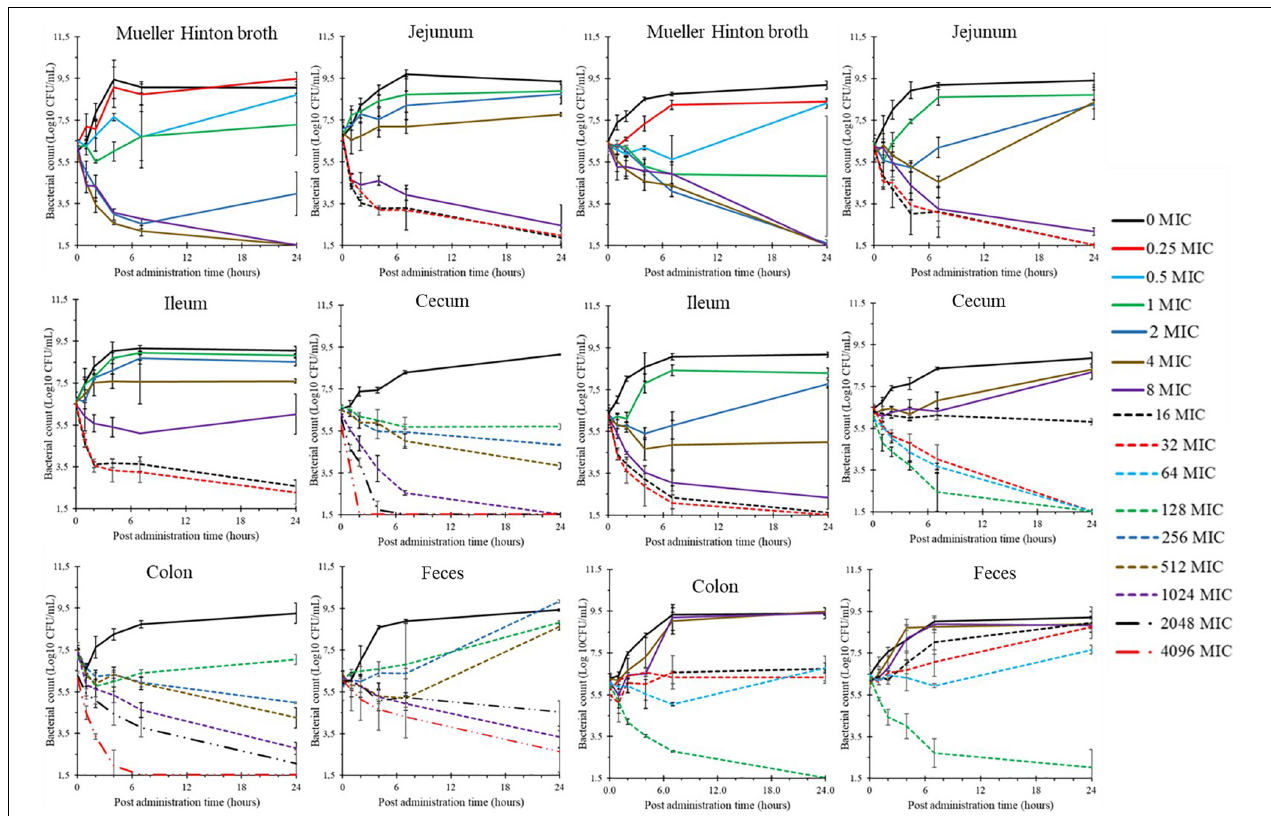
FIGURE 2 | Time-kill curves of minocycline against ATCC25922 (left) and 2S1F2 (right) Escherichia coli strains tested in MHB and SIC (from jejunum, ileum, cecum, colon, and feces); points are mean ± SD ( n = 3 for each matrix and